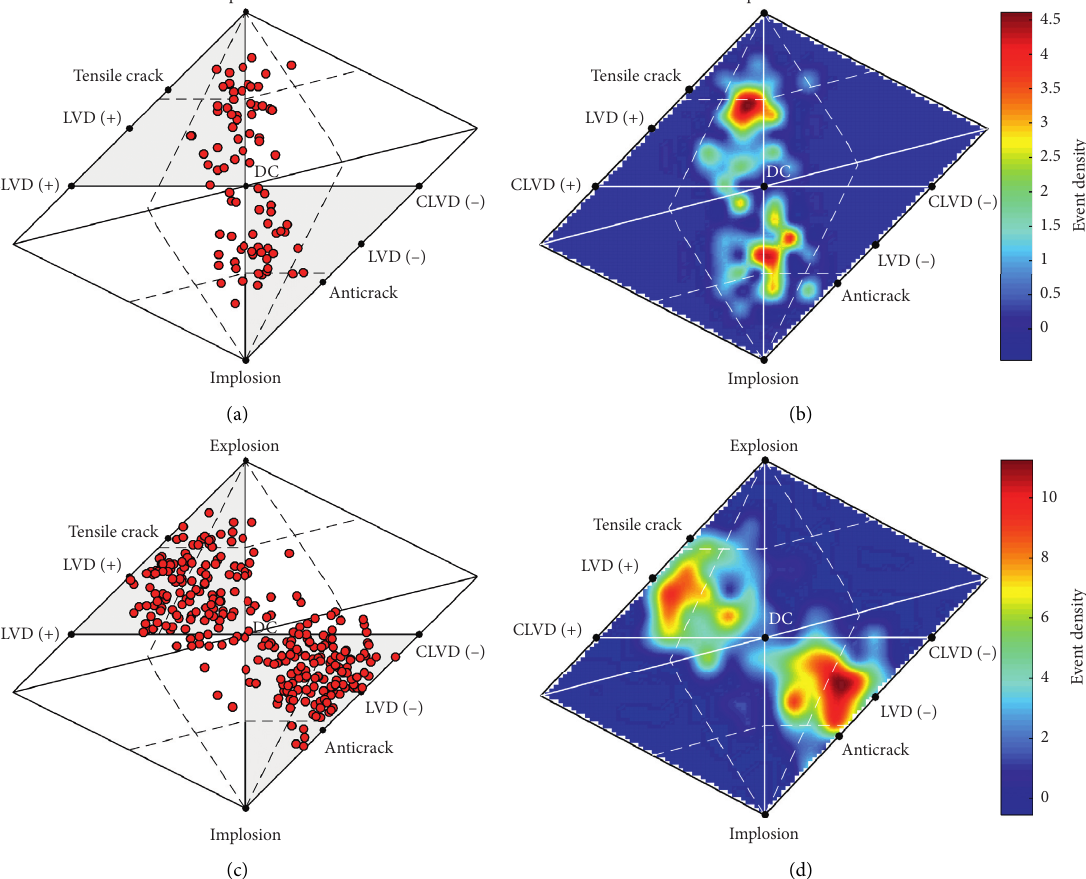
Figure 11: Scatter and density source plots of the MS events with Hudson diagrams ( T - k plot). (a, c) Scatter plot of MS events. (b, d) Density source plot of MTs from MS data (colored according to relative seismic event density). (a) Scatter plot (crack extension stage). (b) Density source plots (crack extension stage). (c) Scatter plot (crack open/close stage). (d) Density source plots (crack open/close